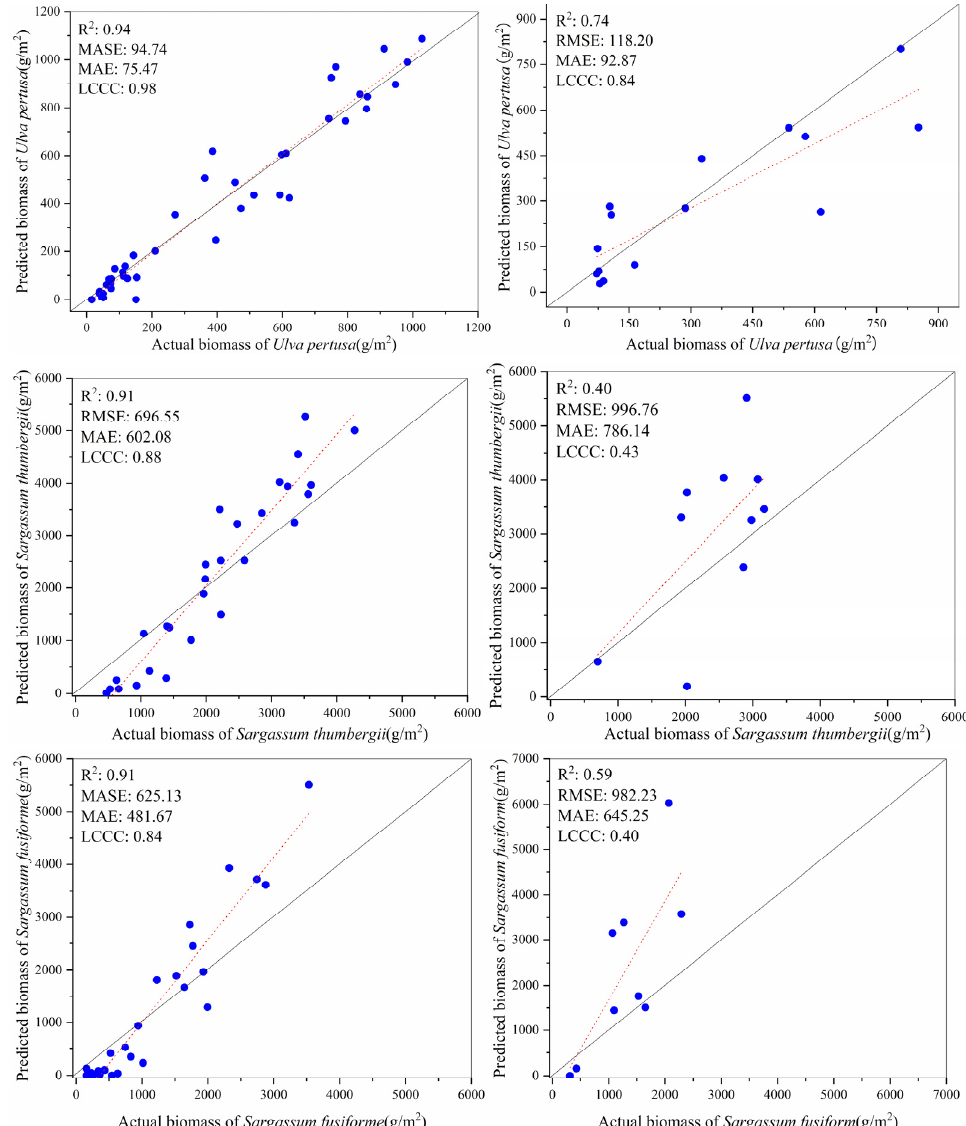
Figure 11. Prediction indices calculated by RF.